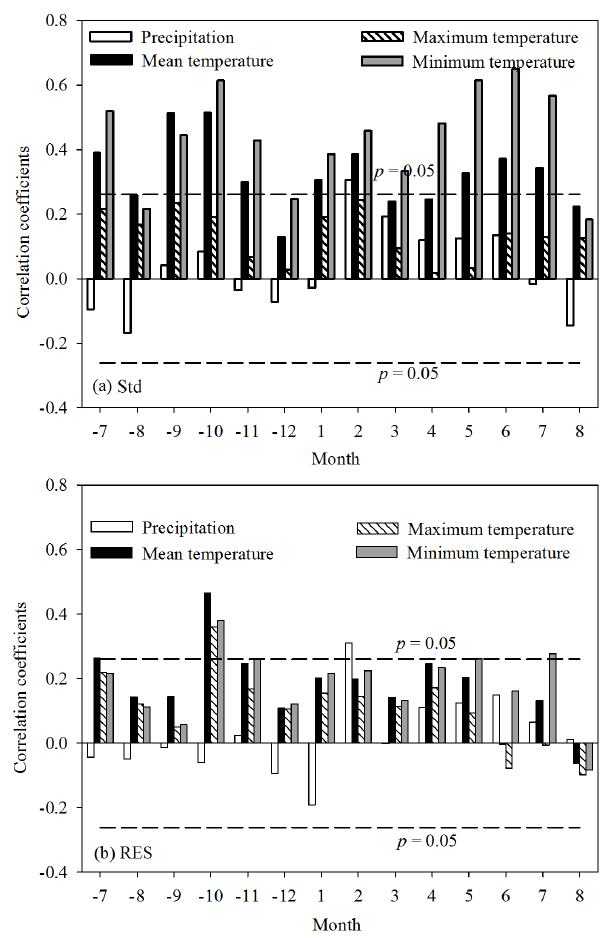
Figure 4. Correlations between the monthly mean meteorologi- cal data (including mean temperature, mean maximum temperature, mean minimum temperature, and total precipitation) from Dunhua meteorological station (1956–2013) and (a) the std chronology and (b) RES chronology. The dashed horizontal line represents the 95% confidence limit.